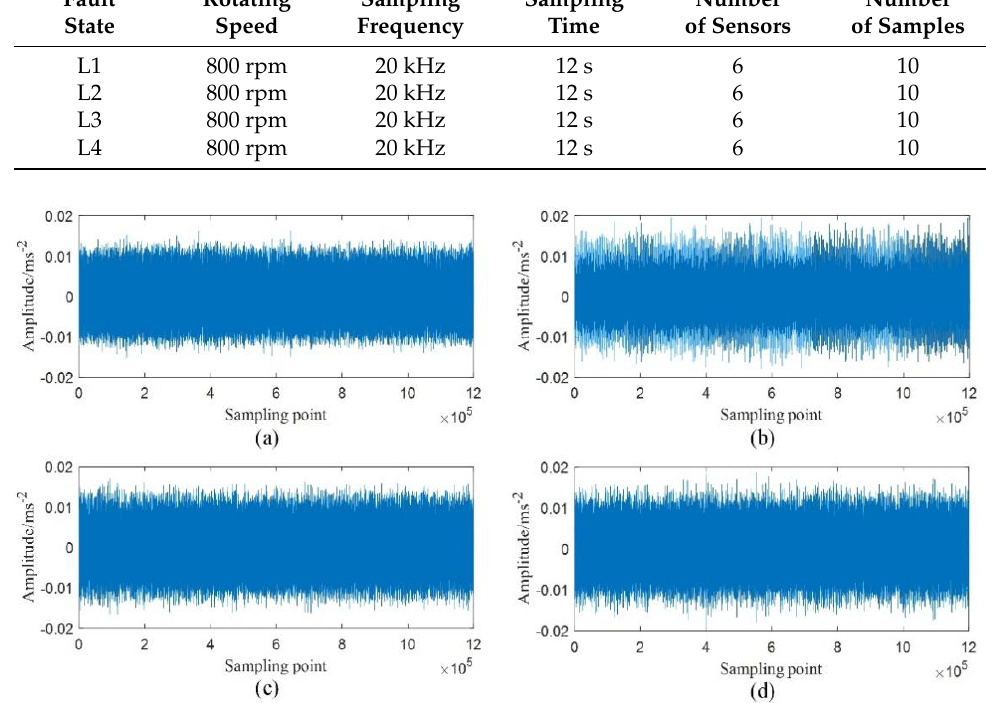
Figure 10. The vibration waveforms of the diesel engine for 4 different states: ( a ) L1 state; ( b ) L2 state; ( c ) L3 state; ( d ) L4 state .